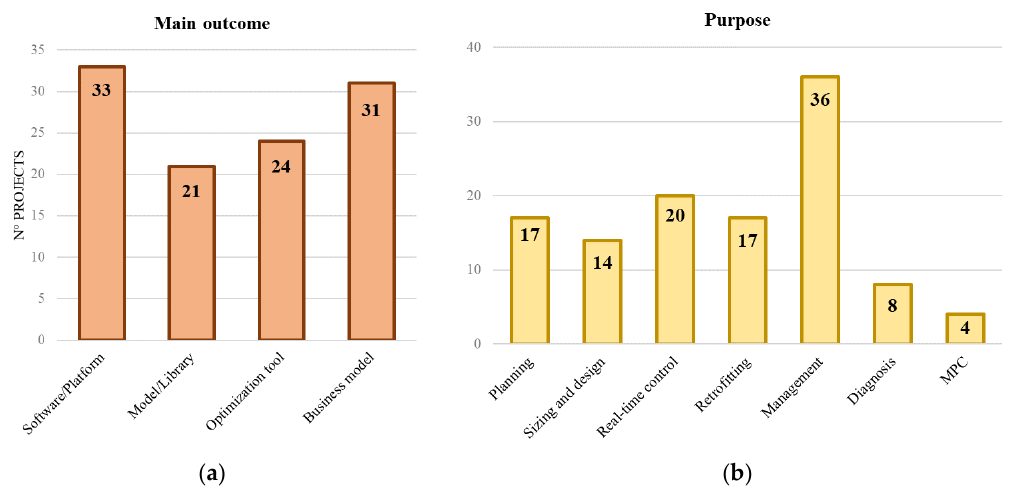
Figure 7. Number of projects per ( a ) main outcome and ( b ) principal purpose of the study. The detailed explanation of the features is reported in Table 1.